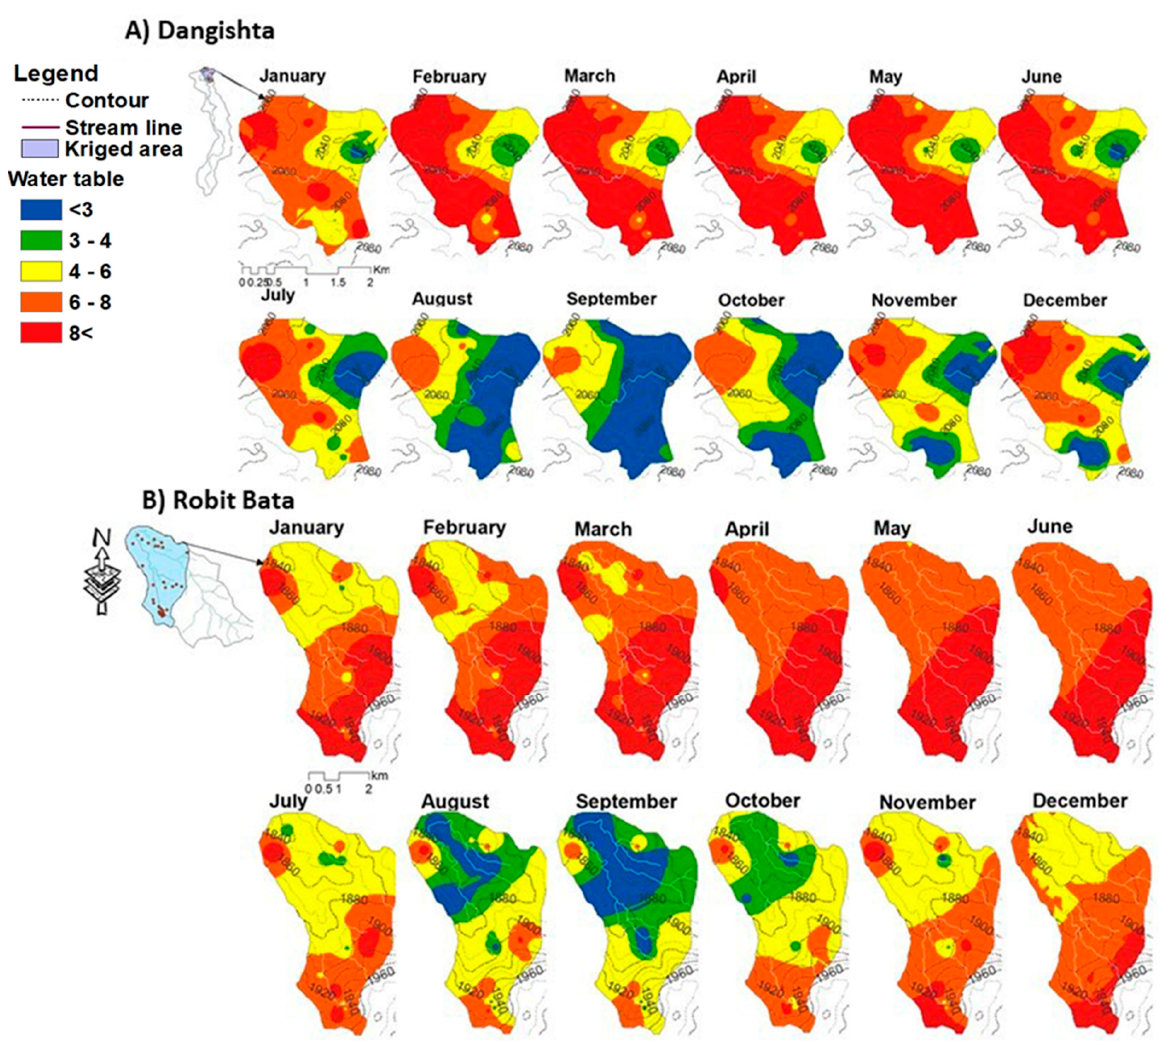
Figure 5. Kriged groundwater table level averaged over 2017 and 2018 for January to December ( A ) Dangishta and ( B ) Robit Bata